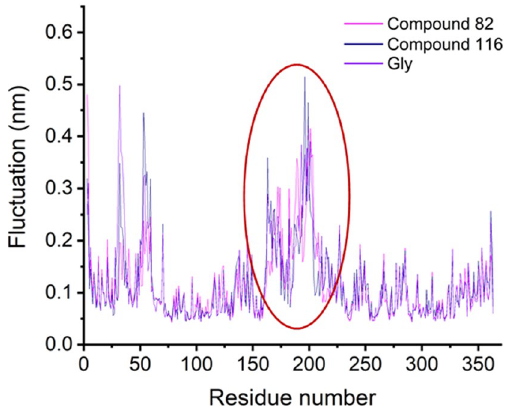
Figure 9. Root Mean Square Fluctuation (RMSF) of compounds 82, 116, and Gly. RC amino acids are presented inside the red